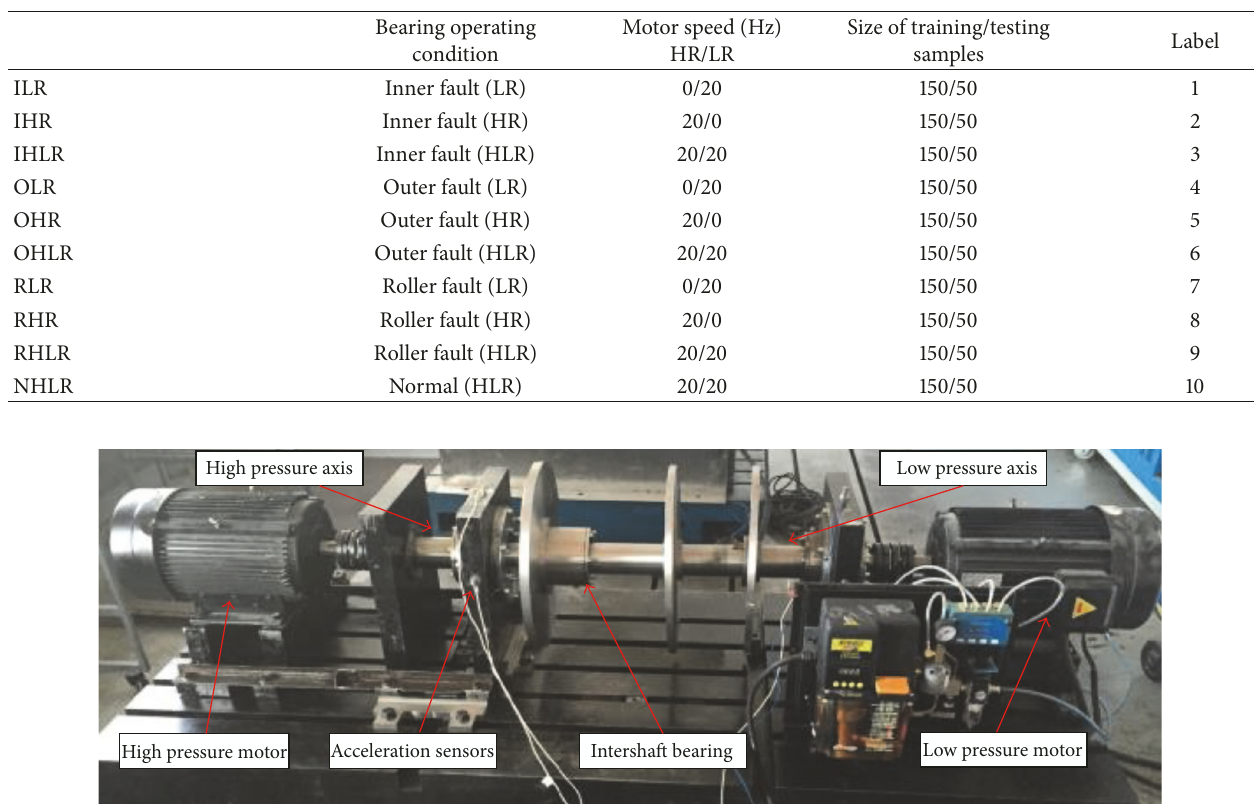
Table 1: Description of the intershaft operation conditions.